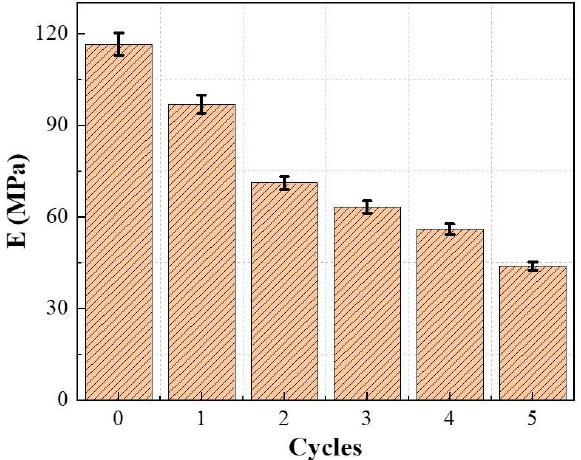
Figure 4. Elastic modulus of specimens at different wet – dry cycles.